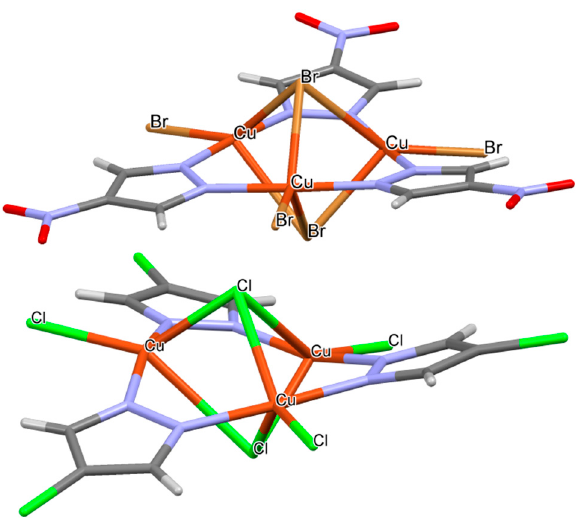
Figure 8. Structure of refcodes ELODOY (up) and OBOQAY (down). Only the (Pz-M) 3 : anions are shown for clarity.